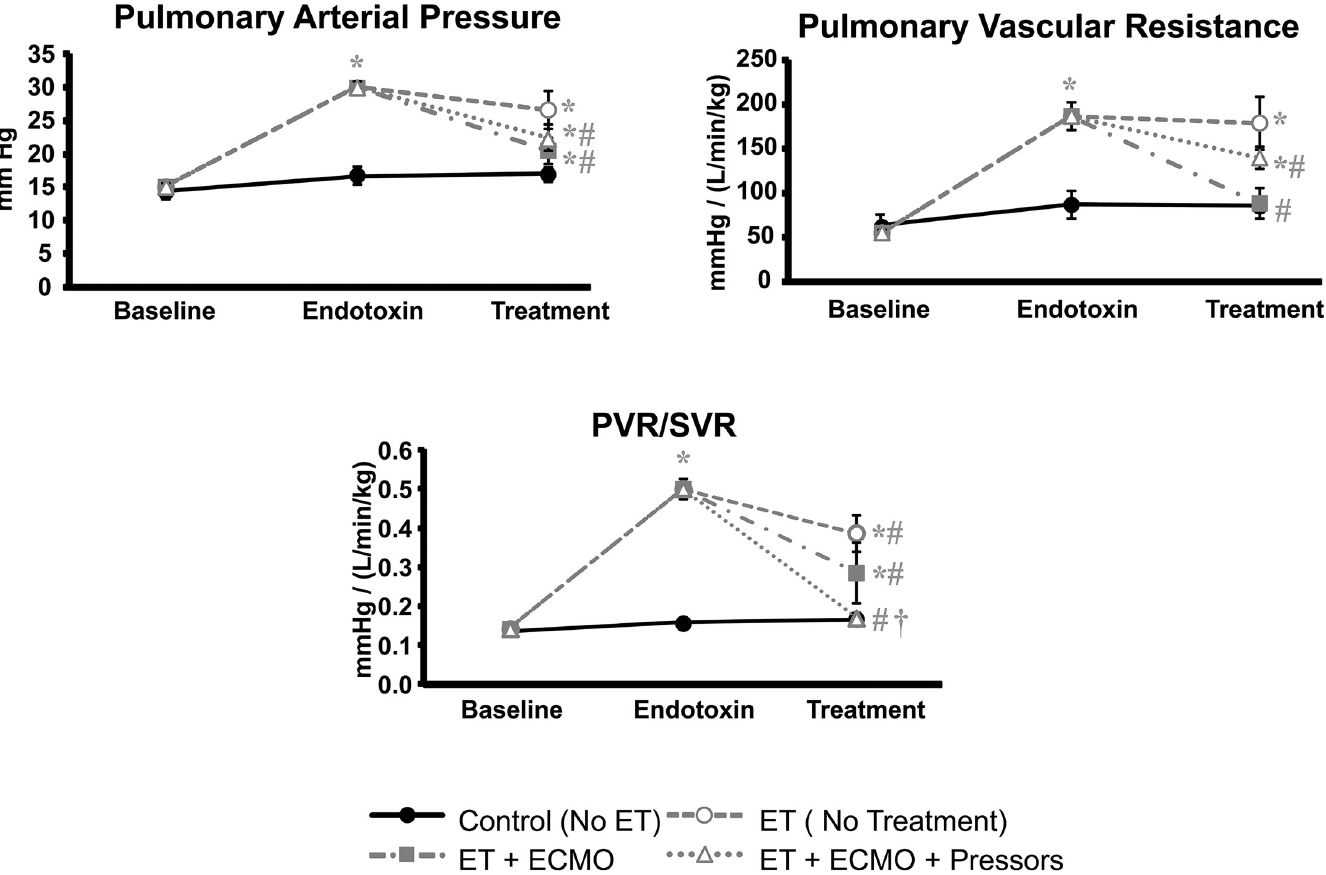
Fig 2. Pulmonary function. A. Pulmonary Artery Pressure B. Pulmonary Vascular Resistance C. PVR/SVR ratio. Values represent mean ± s.e.m. � = significantly different from baseline, p < 0.05. # = significantly different from ET during endotoxin period 2, p < 0.05. † = significant difference between ECMO only and ECMO plus vasopressors, p <